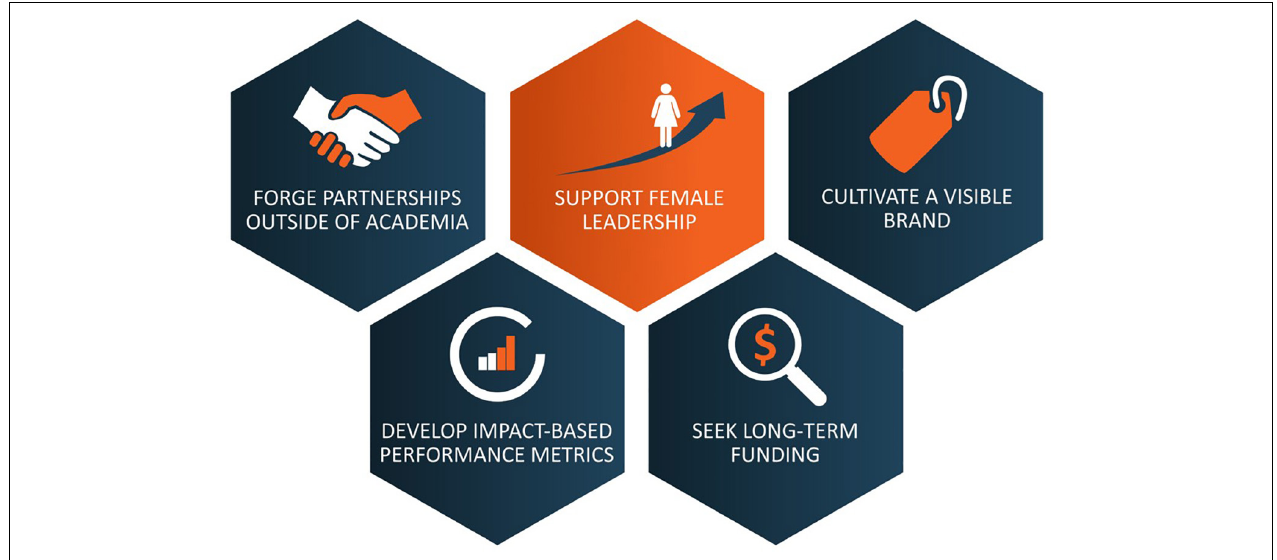
FIGURE 1 | Five principles for building effective interdisciplinary research organizations to tackle complex marine social-ecological challenges. The principles were derived from qualitative data generated from interviews with 18 members of the Centre for Marine Socioecology in Tasmania, Australia, following Grounded Theory Analysis. The order and color of presentation is not indicative of